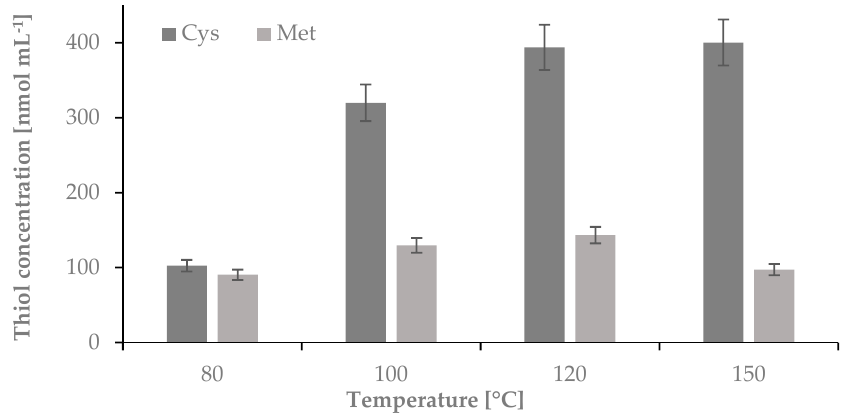
Figure 2. The influence of temperature on the hydrolysis yield of nail plate samples, measured as signals of cysteine-2-chloro-1-methylquinolinium tetrafluoroborate and methionine- o -phthaldialdehyde-N-acetylcysteine derivatives; n = 3.